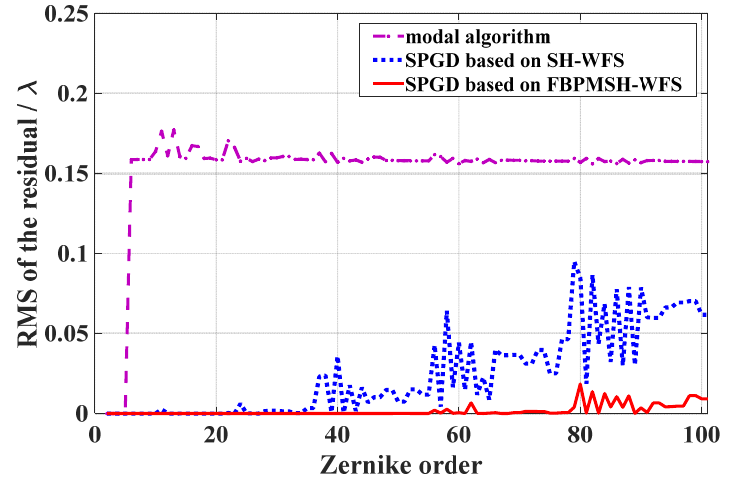
Figure 3. Recovery results for single-order Zernike polynomials.